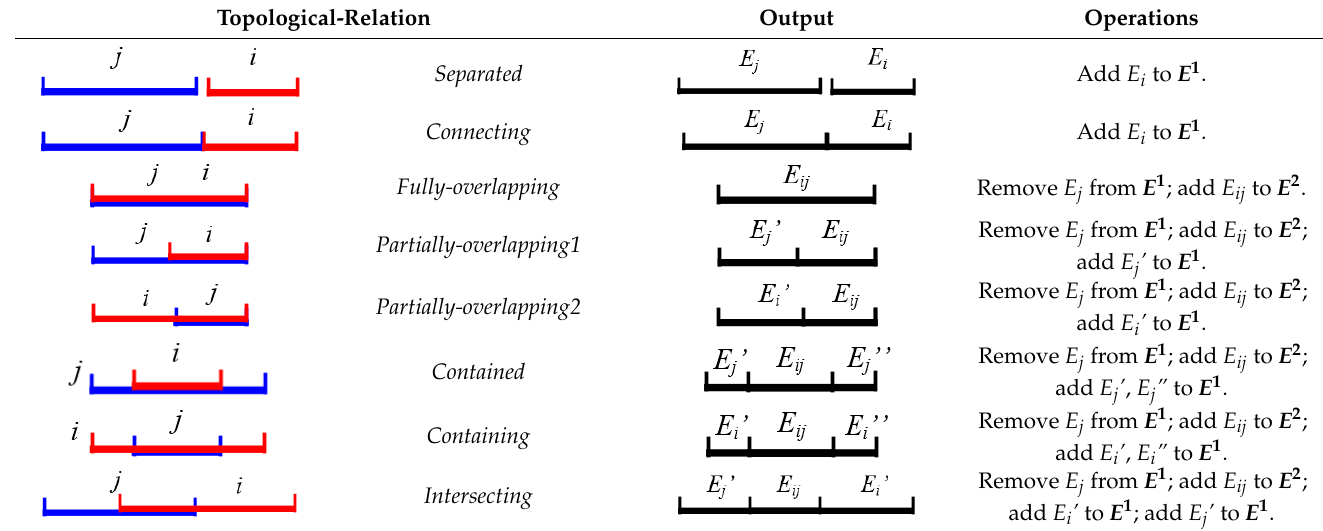
Table 3. 1D topological relations between the co-linear 3D edges and corresponding operations. Topological-Relation